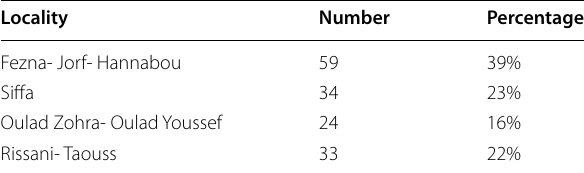
Table 1 Distribution of operating khettaras by localities in the plain of Tafilalet